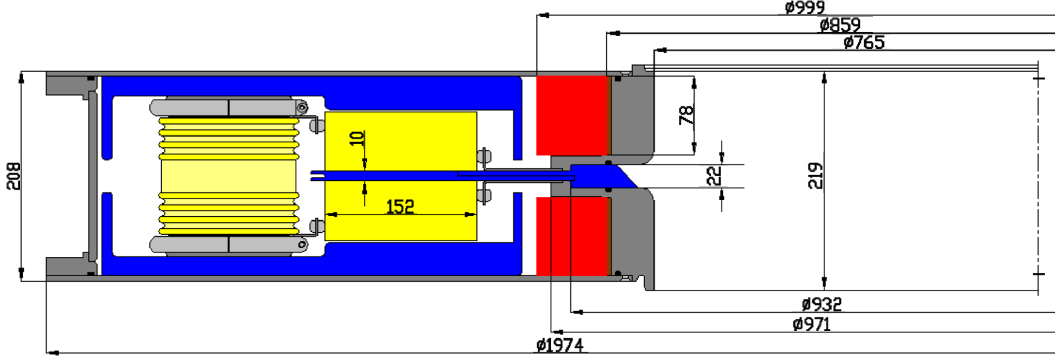
FIG. 2. Side view of the LTD cavity with 5th harmonics and total number of the bricks s þ m þ f ¼ 20